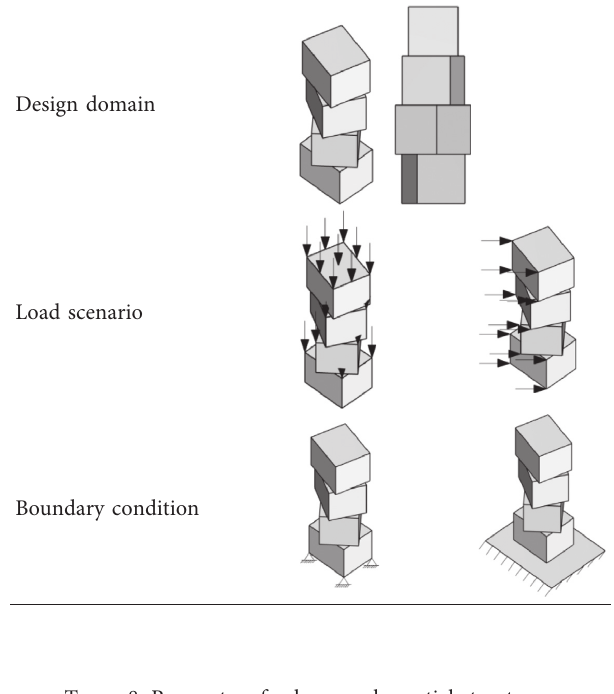
Table 7: Parameters for multistorey buildings.